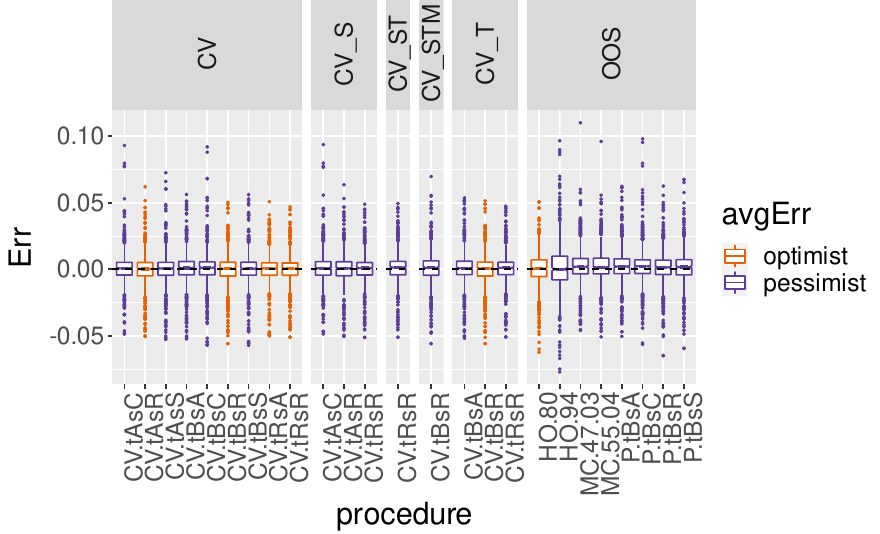
Figure 10. Box plots of estimation errors incurred by cross-validation and out-of-sample procedures on 192 artificial datasets using four learning